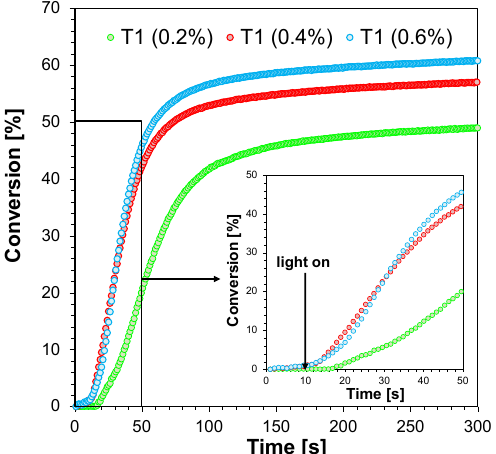
Table 4 Functional group conversions of acrylate monomer TMPTA using different concentration of a photoinitiator T1 under LED 405nm.